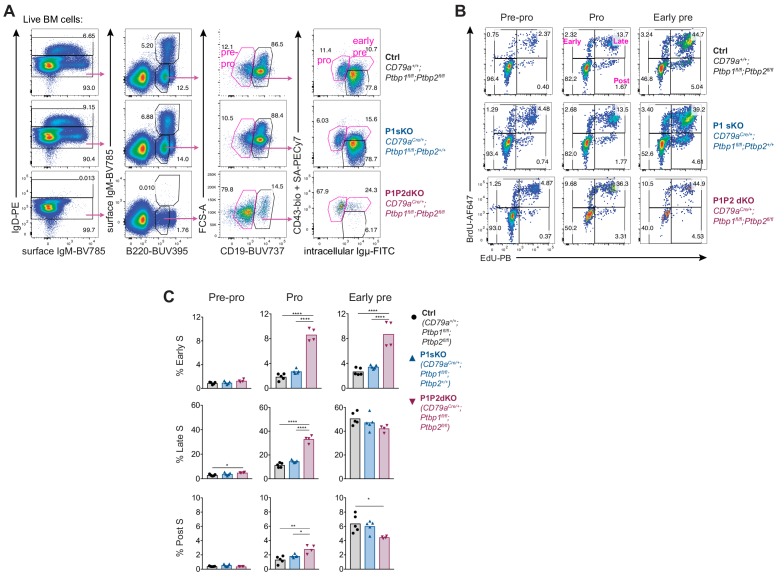
Cell cycle analysis in pro-B cells.(A) Gating strategy to identify pre-pro-, pro- and early-pre-B cells in EdU and BrdU sequential labelling experiments in live bone marrow cells from the indicated genotypes. (B) Early-, late- and post-S-phase gating amongst pre-pro-, pro- and early-pre-B cells identified as shown in A. (C) Proportions of early, late and post S-phase cells amongst pre-pro-, pro- and early-pre-B cells identified as shown in A and B. Data shown are from one out of two independent experiments. Bars show arithmetic means, each point shows data from an individual mouse and P-values were calculated by one-way ANOVA with Tukey's multiple comparisons test. Summary adjusted p-value *<0.05, **<0.01, ***<0.001, ****<0.0001.